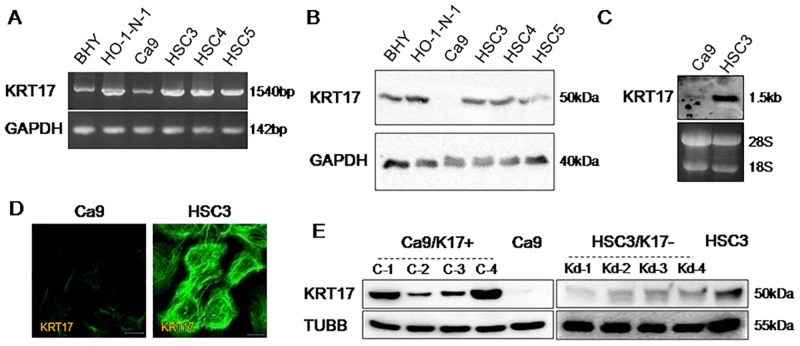
Generation of KRT17-overexpressing and KRT17-knockdown oral cancer cell lines.(A) Agarose gel electrophoresis of RT-PCR assays for the identification of KRT17 and GAPDH in various oral cancer cell lines. (B) Western blot analysis of various oral cancer cell lines for detection of KRT17 and GAPDH. (C) Northern blot analysis of Ca9 and HSC3 cells by hybridization with a KRT17 probe. (D) Immunofluorescent images showing filamentous staining of KRT17 in Ca9 (faint) and HSC3 cells. Scale bar, 10 μm. (E) Western blot analysis of KRT17-overexpressing Ca9 (Ca9/K17+) clones (C-1, C-2, C-3, and C-4), the parental Ca9 cells, KRT17-knockdown HSC3 (HSC3/K17-) clones (Kd-1, Kd-2, Kd-3, and Kd-4) and the parental HSC3 cells for detection of KRT17 and beta1-tubulin (TUBB). KRT17 cDNA was transfected into Ca9 to make KRT17-overexpressing cells (Ca9/K17+), and four independent clones (C-1, C-2, C-3, and C-4) were established. KRT17 expression in HSC3 was suppressed by miRNA-mediated knockdown, and four independent clones (Kd-1, Kd-2, Kd-3, and Kd-4) of KRT17-knockdown cells (HSC3/K17-) were established.